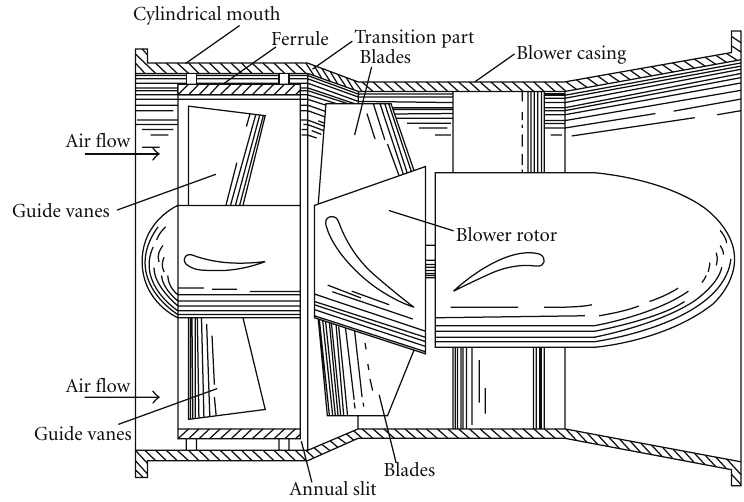
Figure 1: The proposed “blower arrangement”